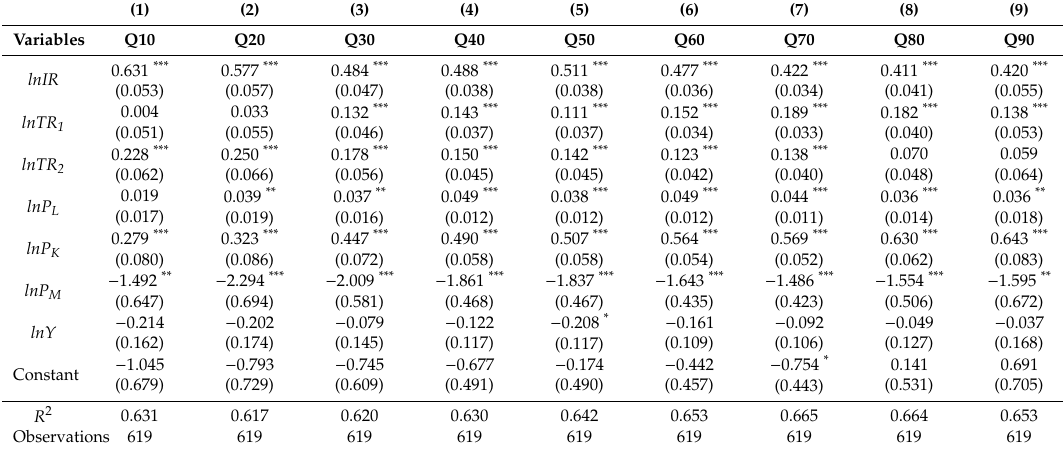
Table A1. Empirical results; conventional quantile regression